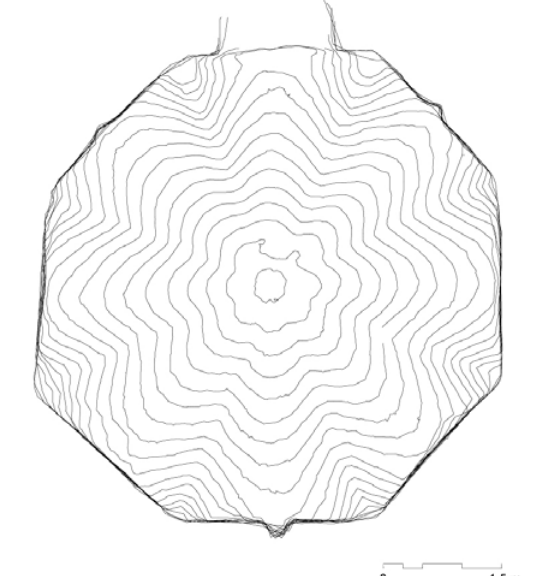
Figure 6. Plan view of the horizontal sections of the points cloud (10 cm distance).